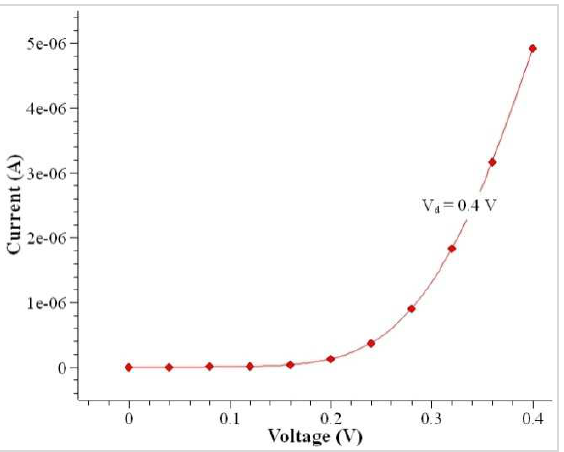
Figure 5. Conduction sub-band profile V D versus V G in the CSDG MOSFET.